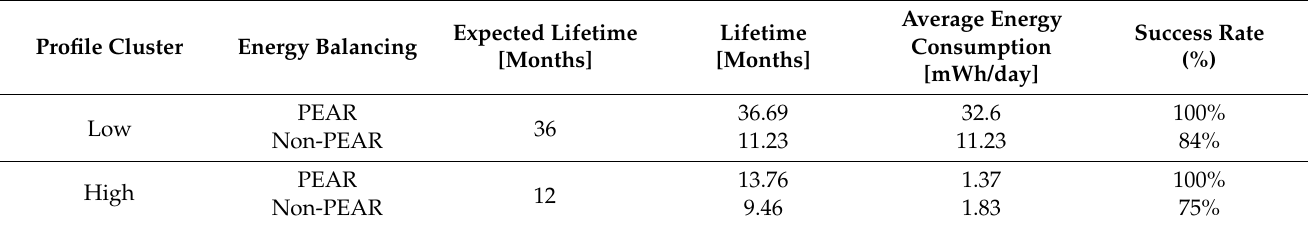
Table 4. The comparison between the PEAR and Non-PEAR per profile cluster for the H20L50